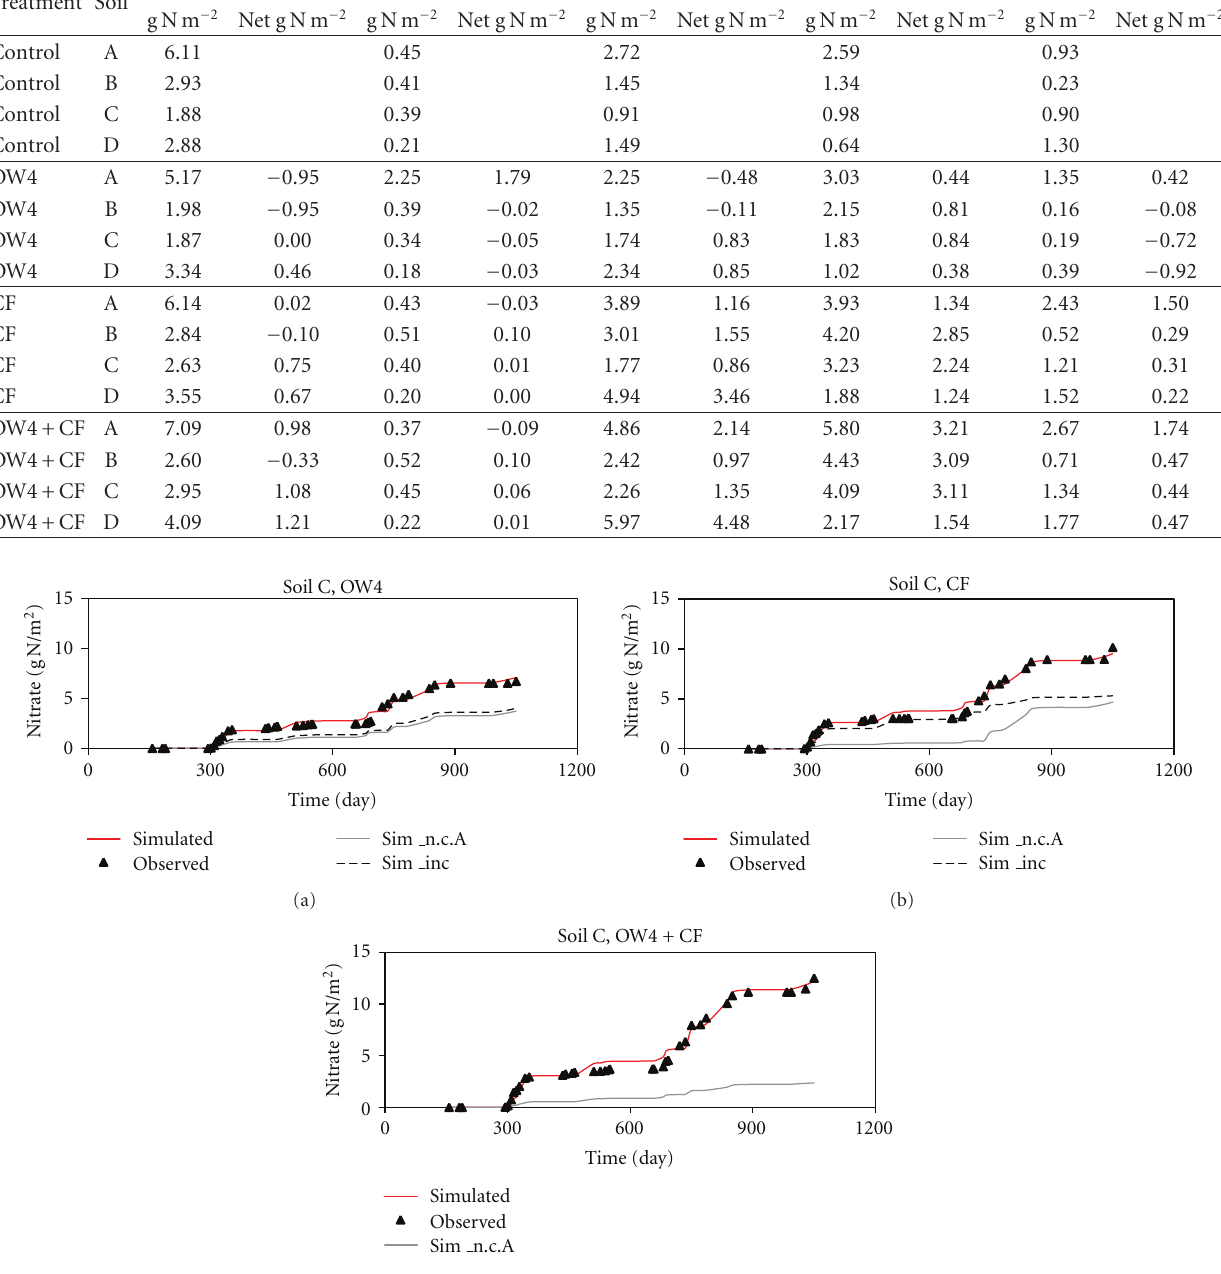
Table 7: Seasonal NO 3 − leaching and net NO 3 − leaching (NO 3 − leaching (treated with organic matter)-NO 3 − leaching (control)). a = autumn, s = spring. Treatment Soil